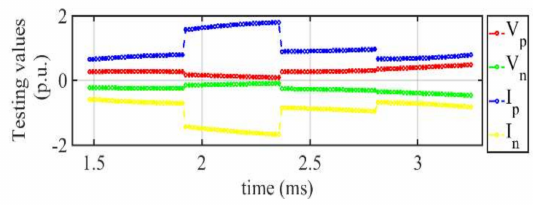
Figure 32. Testing values of the SVM algorithm under PP